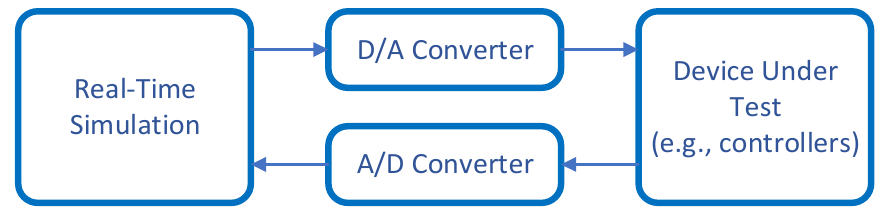
Figure 3. Controller hardware-in-the-loop (CHIL), adapted from [57].